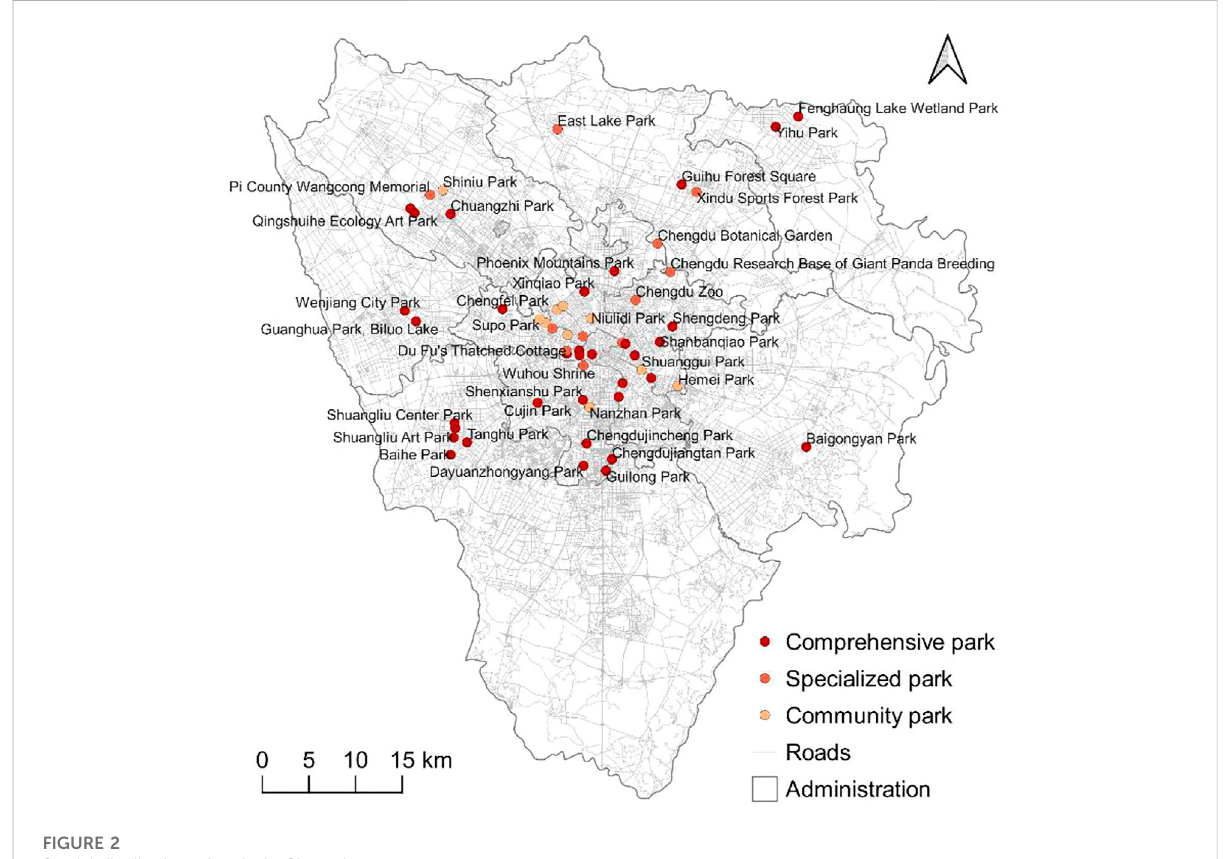
FIGURE 2 Spatial distribution of parks in Chengdu.